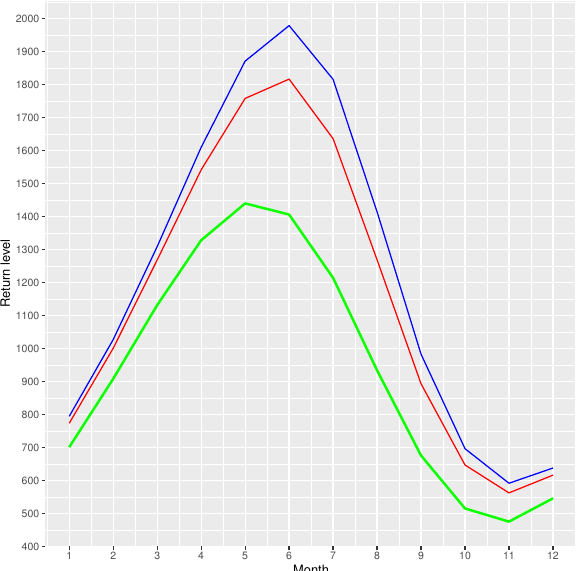
Figure 13. Return levels expected every 10, 50 and 100 years. Green: expected return every 10 years; red: expected return every 50 years; blue: expected return every 100